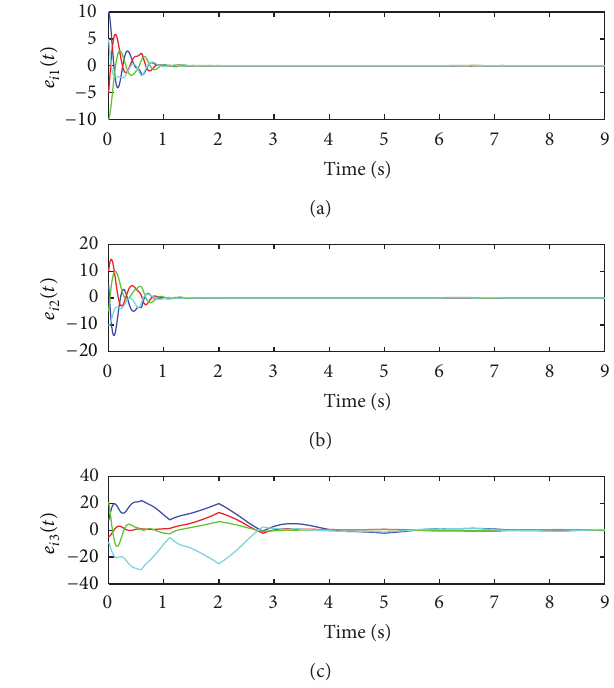
Figure 9: Synchronization errors between the states of node 𝑖 and node 𝑖 + 1 for the switched delay network (75).